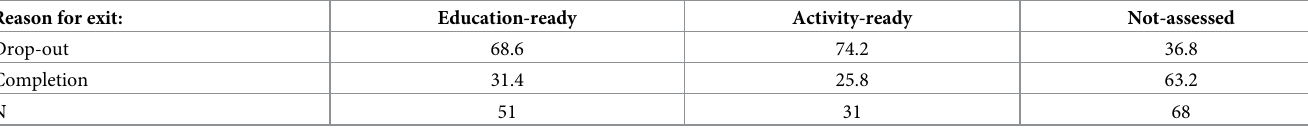
Table 4. Reason for ending educational activities among young adults with low qualifications by assessment category, (%). Reason for exit: